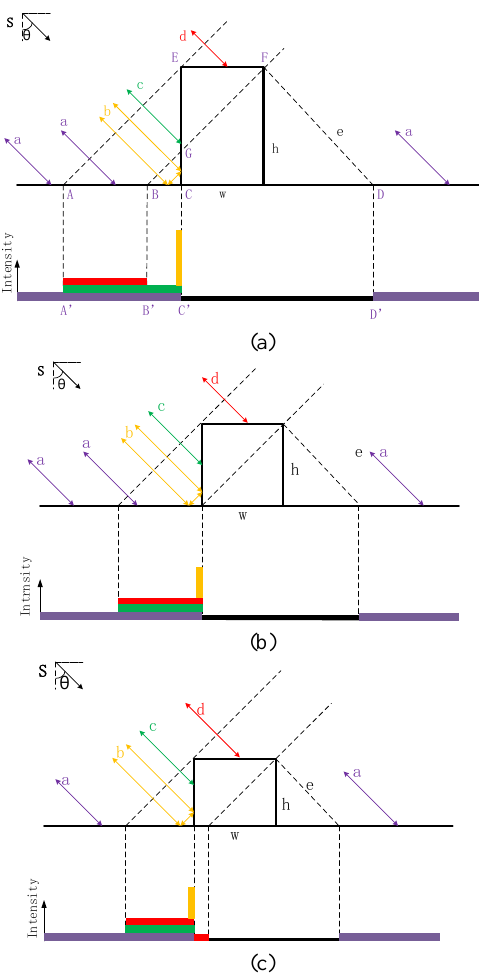
Figure 1. Scattering from a simple flat roof building model with width w and heights h : ground scattering a; double bounce b; scattering from vertical wall c; backscattering from roof d; shadow area e. The gray values in the backscattering profiles correspond to the relative amplitudes. (a) h > w • tan( θ ). (b) h = w • tan( θ ). (c) h < w • tan( θ ). (Brunner, 2009, modified ） With the decrease of the height of the building ( h = w • tan( θ ), h < w • tan( θ )), the position of backscattering wave b from roof EF and double bounce backscattering wave from EC and ground moves relatively back to side of the sensor, formed the imaging geometry structure diagram as Figure 1b and 1c